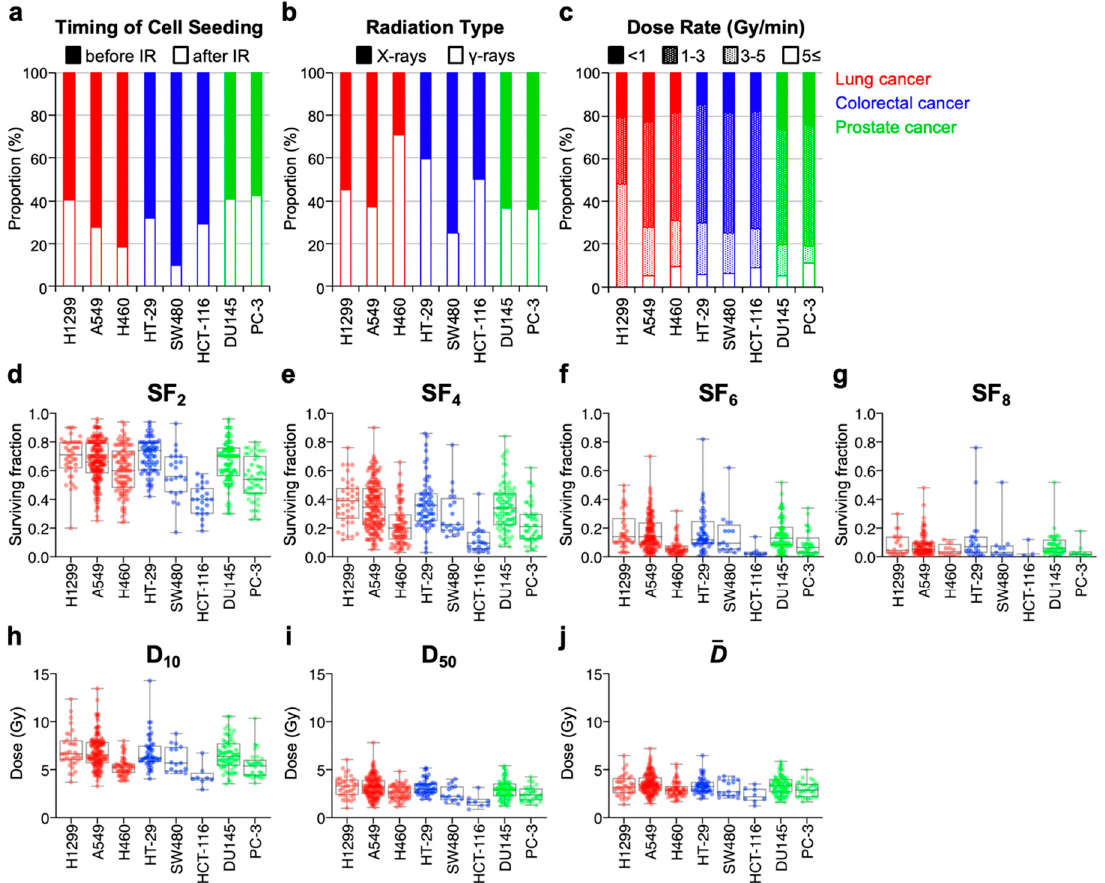
Figure 2. Summary of clonogenic assay data acquired from the literature. ( a ) Timing of cell seeding. ( b ) Radiation type. ( c ) Dose rate. ( d ) SF 2 . ( e ) SF 4 . ( f ) SF 6 . ( g ) SF 8 . ( h ) D 10 . ( i ) D 50 . ( j ) 𝐷 . IR, irradiation.